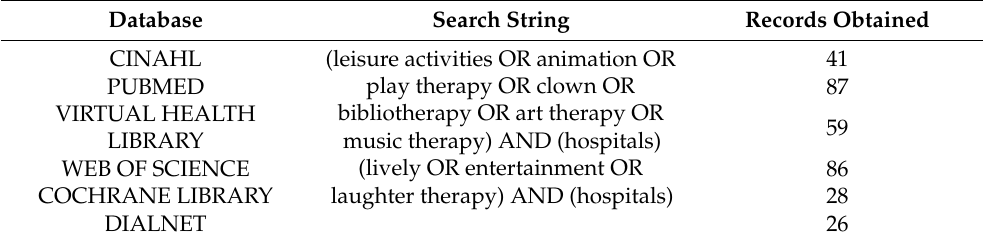
Table 1. Database search